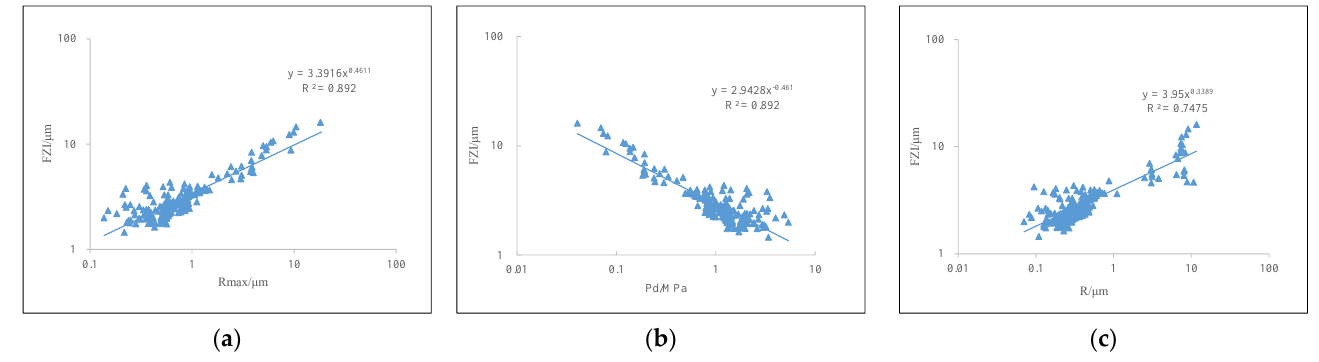
Figure 6. Relationship between FZI and maximum pore throat radius, displacement pressure, and average throat radius. ( a ) Maximum pore throat radius; ( b ) displacement pressure; ( c ) average throat radius.